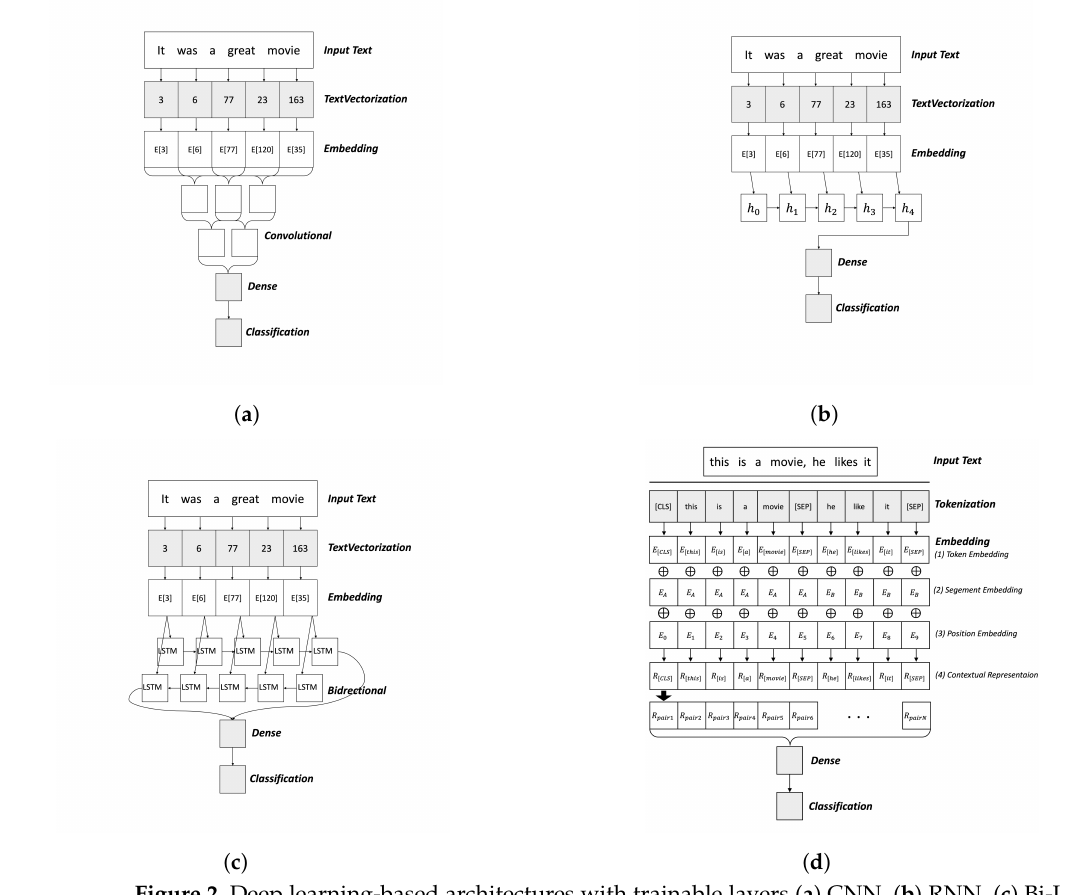
Figure 2. Deep learning-based architectures with trainable layers ( a ) CNN, ( b ) RNN, ( c ) Bi-LSTM, ( d )